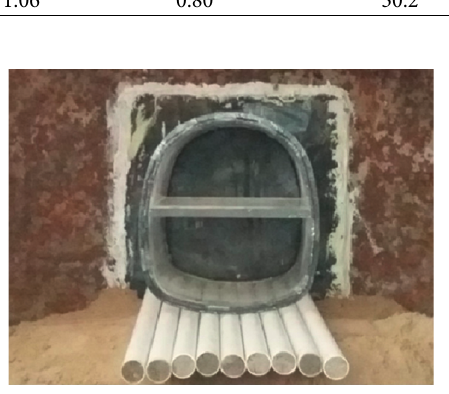
Figure 15: Indoor similarity test model. Table 4: Comparison table of the tunnel support structure prototype materials and the model